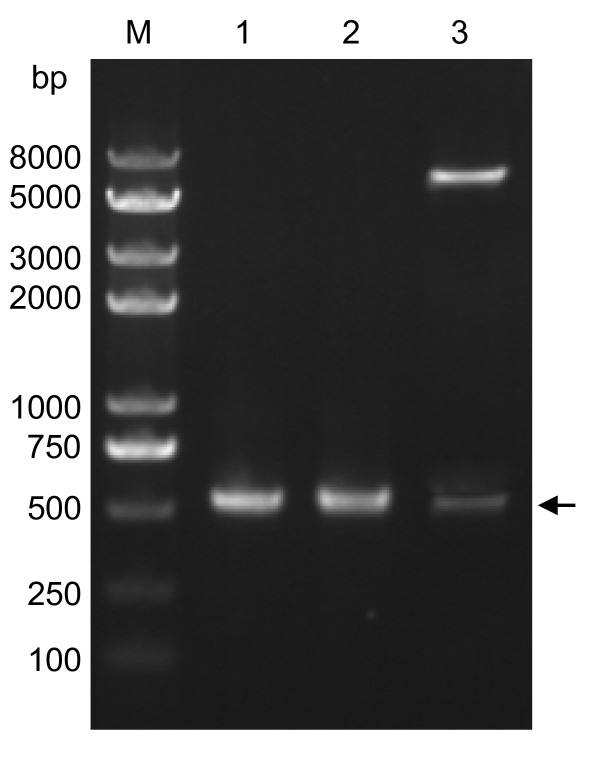
Construction of the recombinant plasmid pET-32a-US11. Lane 1, the PCR product of the US11 gene; Lane 2, the recombinant plasmid pET-32a-US11 was confirmed by PCR; Lane 3, the recombinant plasmid pET-32a-US11 digested with EcoRI and SalI; and Lane M, the DNA marker. Arrowhead indicates the position of the US11 fragment.